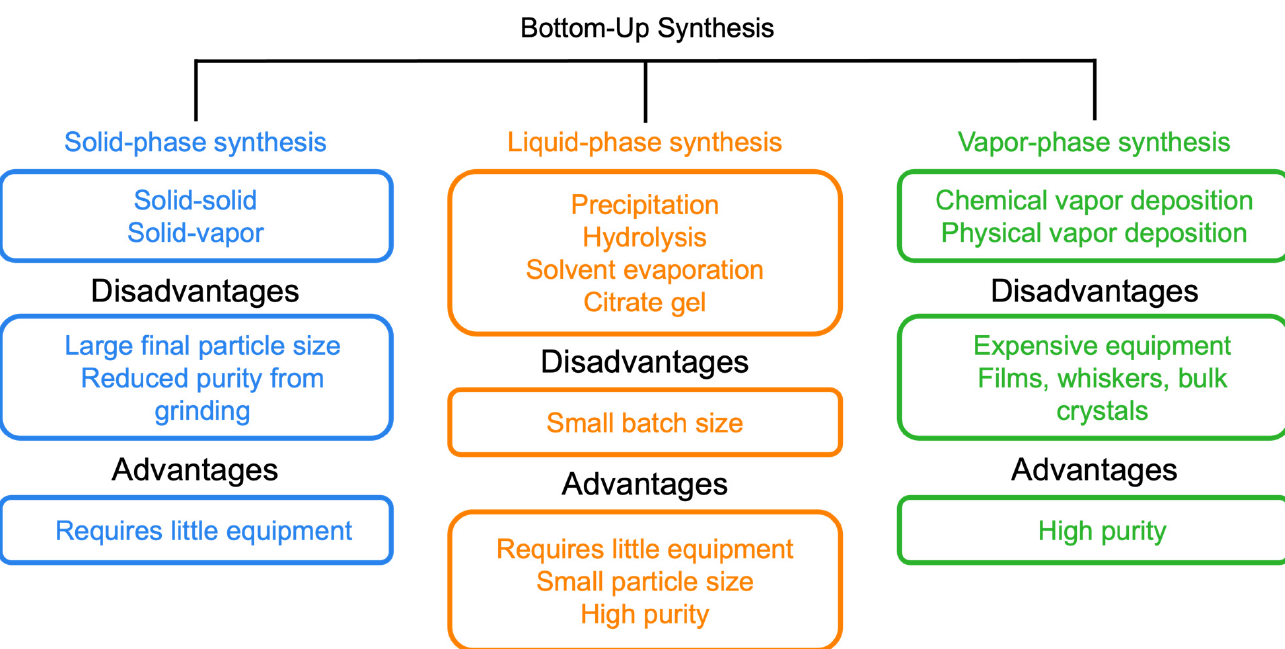
Figure 1. Examples of the three types of synthesis methods (solid-phase, liquid-phase, and vapor- phase) and the pros and cons of each used in bottom-up synthesis. Due to issues with solid-phase and vapor-phase synthesis methods, liquid-phase synthesis is generally the desired synthesis method for high purity nanoparticles.